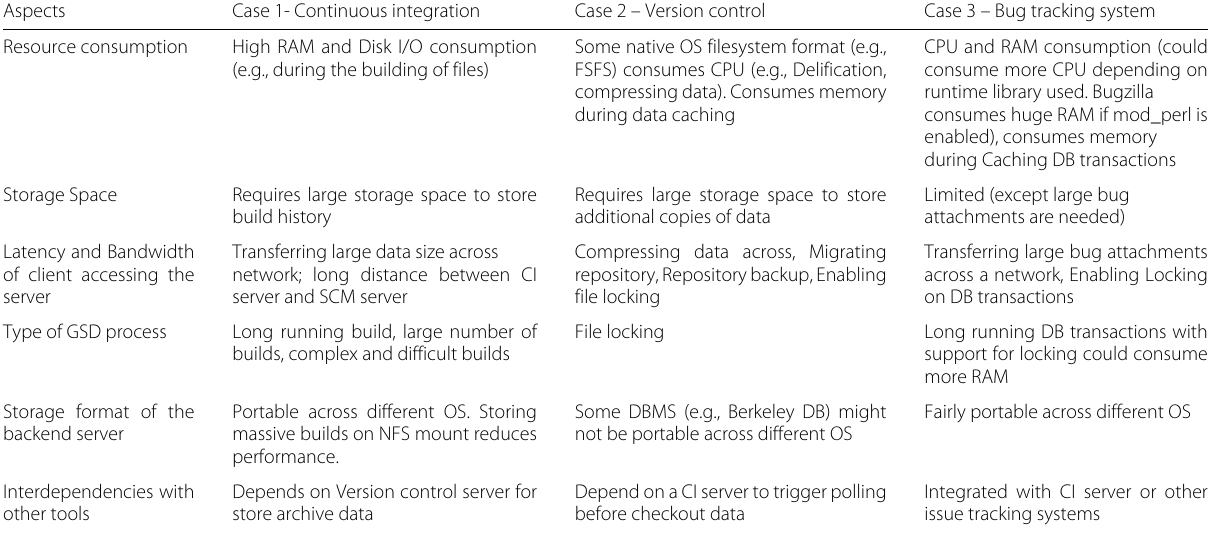
Table 7 Comparison of different aspects in which the Cases vary